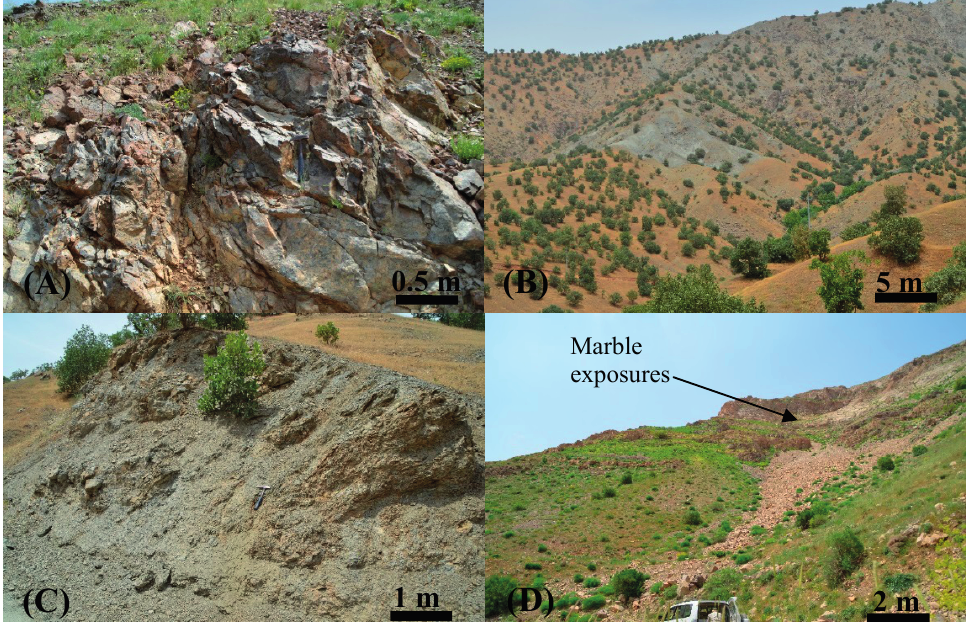
Figure 3. Photographs of the lithological units in the study area: ( A ) ultramafic (harzburgite); ( B ) gabbro, ( C ) metabasalt, and ( D ) marble exposures above ultramafic